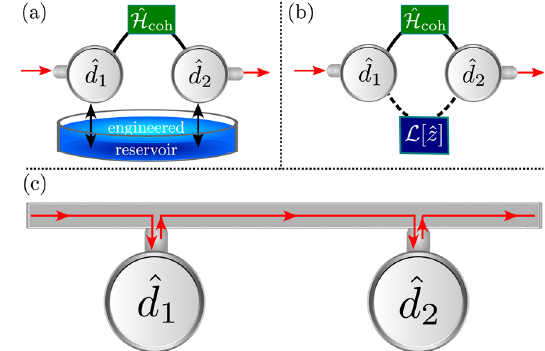
FIG. 1. (a) Basic recipe for generating directionality: Two cavities are directly coupled to one another via a coherent ˆ H Hamiltonian , and are also each coupled to the same coh (nondirectional) dissipative environment. (b) The dissipative environment in (a) mediates a reciprocal dissipative interaction between the two cavities. This interaction can be modeled using a Lindblad master equation and dissipative superoperator L ½ ˆ z (cid:2) [cf. Eq. (2)]. By balancing the strength of coherent and bath- induced dissipative interactions between the cavities, one can break reciprocity. (c) Schematic cascaded quantum system, where one cavity drives another via a waveguide supporting only a right- propagating mode. The effective theory used to describe such systems corresponds to